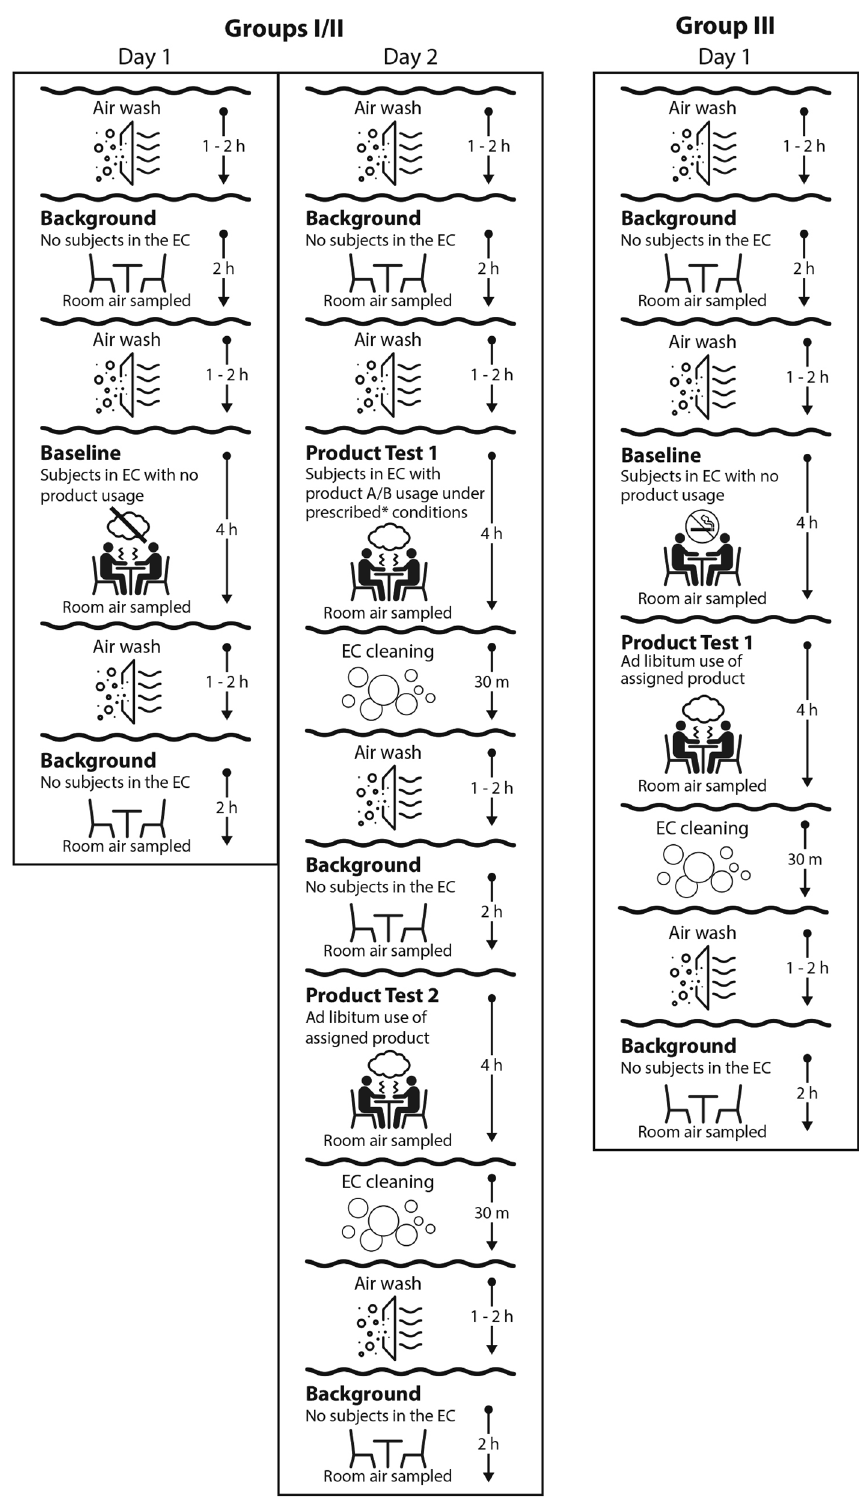
Figure 4. Study schedule for all